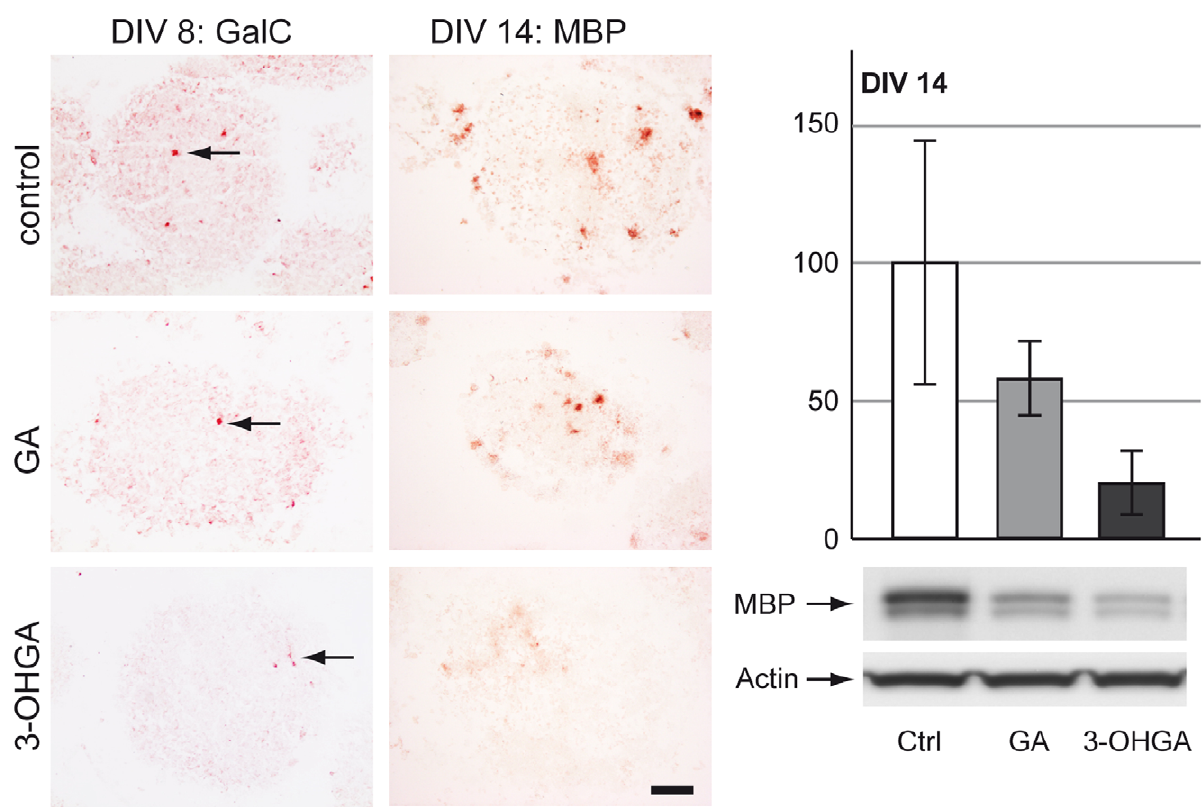
Figure 4. Effects of GA and 3-OHGA on oligodendrocytes. (Left panel) Immunohistochemical staining for galactocerebroside (GalC, DIV 8) and myelin basic protein (MBP, DIV 14) on cryosections derived from protocol A (DIV 8) and protocol B (DIV 14). Oligodendrocytes are indicated by black arrows. Scale bar: 100 m m. (Right panel) Representative western blots with data quantification of whole-cell lysates for MBP for protocol B (DIV 14). Actin was used as a loading control. The quantifications of MBP levels are expressed as percentage of respective controls. The values represent the mean 6 SD from 3 replicates taken from 2 independent experiments.